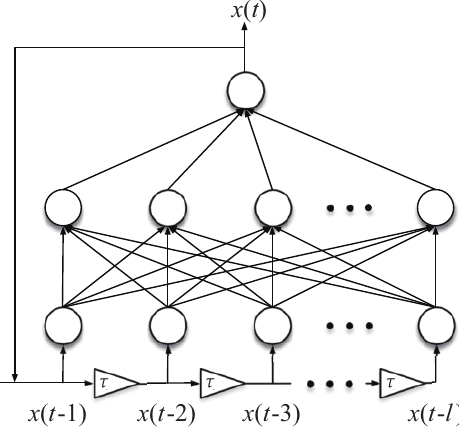
Fig. 2 Autoregressive neural network